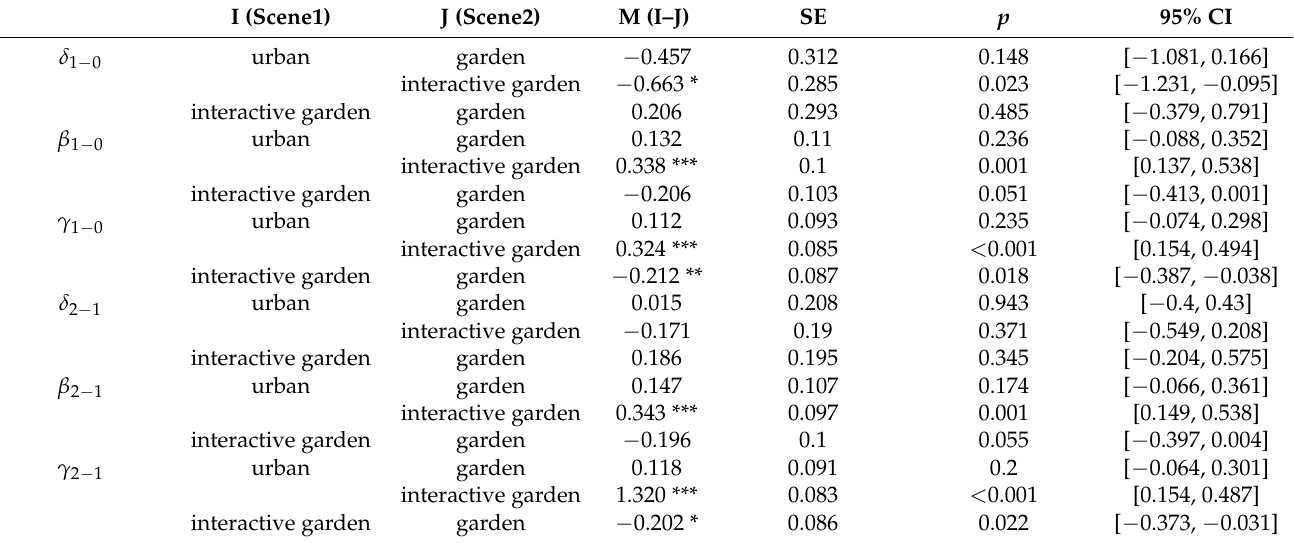
Table A12. Post-test